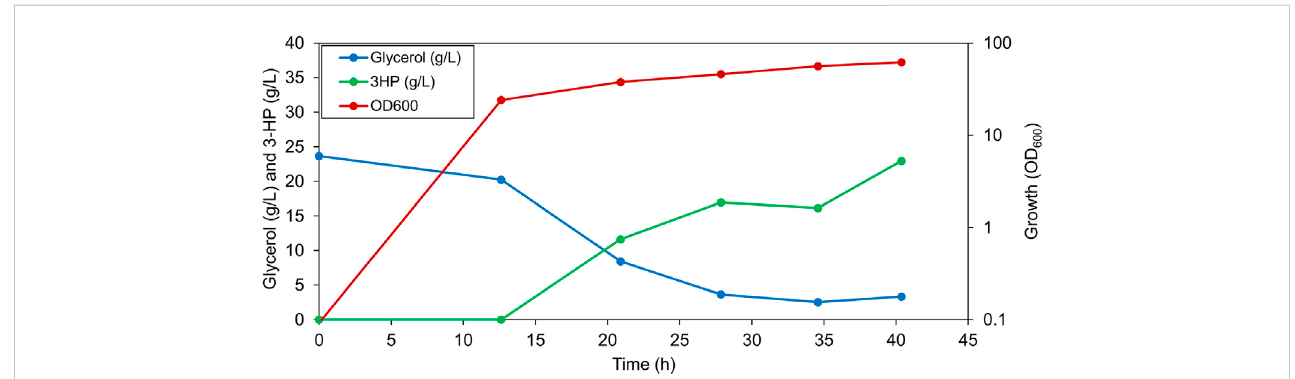
FIGURE 4 Representative graph depicting 3-HP production, residual glycerol in the broth and the OD 600 value of PS4mut in a 1-L bioreactor cultured under 1% dissolved oxygen and 2% glycerol.